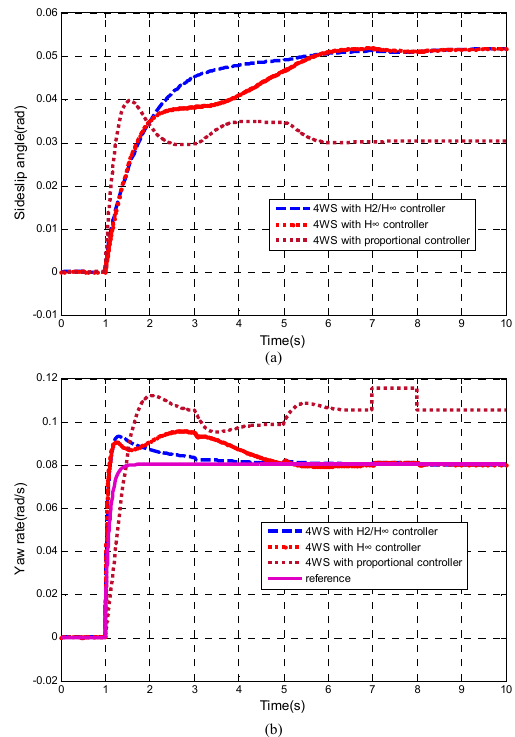
Figure 18. The step responses of the front wheel angle under interferences: ( a ) sideslip angle response; ( b ) yaw rate response.